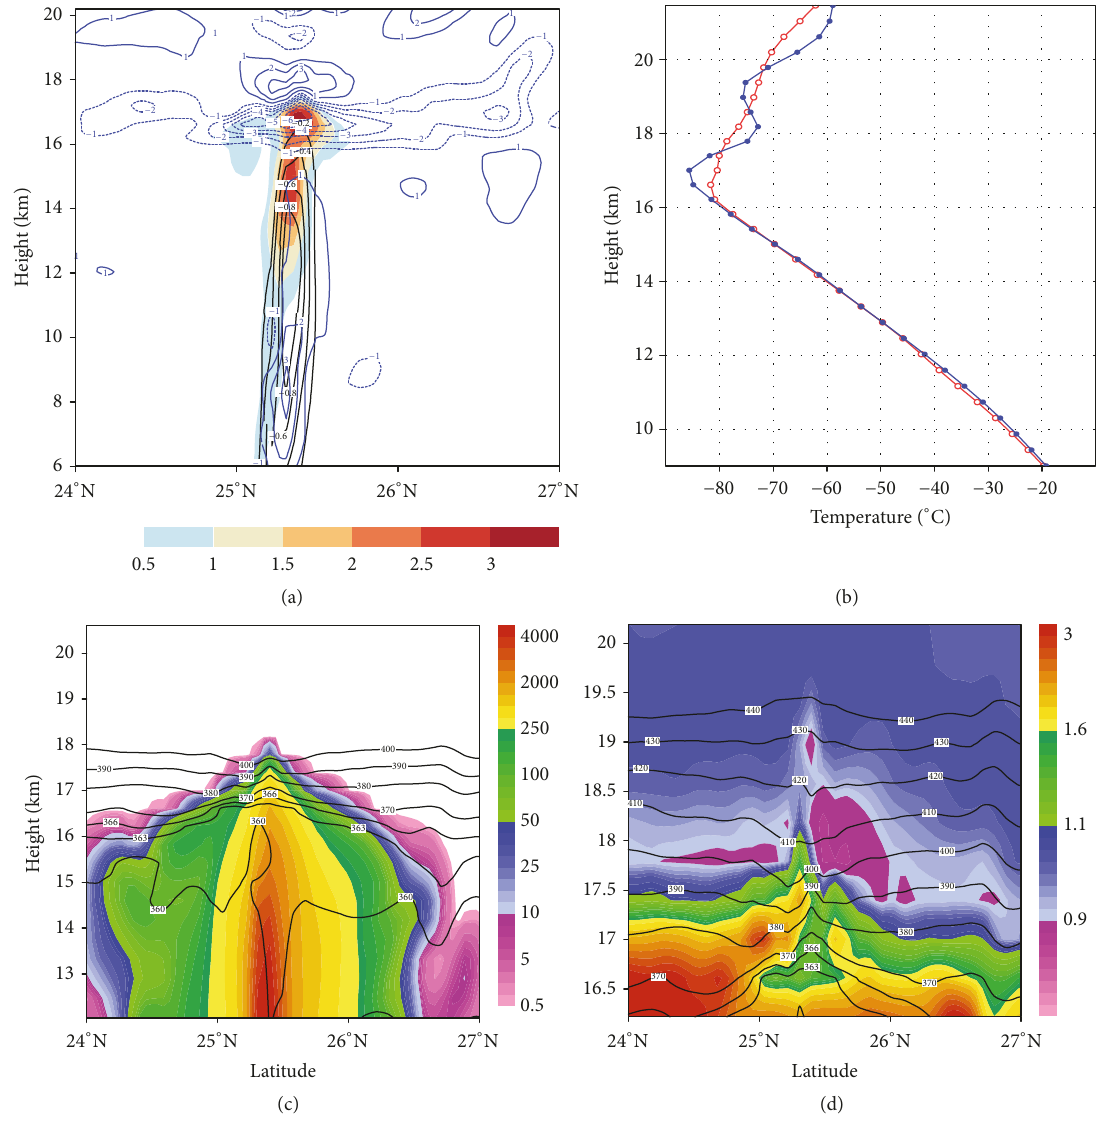
Figure 6: Meridional cross-sections along 107.3 ∘ E in the mature stage of the MCC from the WRF simulations. (a) Divergence (10 −3 s −1 , shading), vertical velocity (Pa ⋅ s −1 , black contours), and meridional temperature deviation ( ∘ C, blue contours). (b) Temperature profiles at the mature (blue curves) and early (red curves) stages of the MCC. (c) Total IWC (mg ⋅ kg −1 , shading) and potential pseudo equivalent temperature (K, black contours). (d) Water vapor content (mg ⋅ kg −1 , shading) and potential pseudo equivalent temperature (K, black